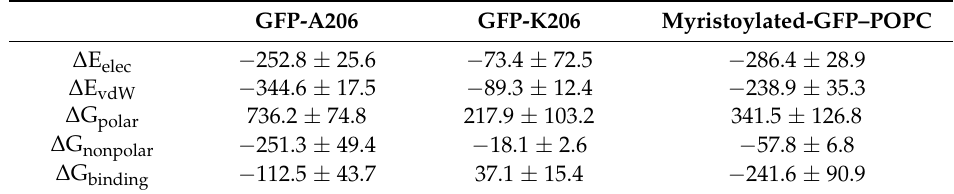
Table 1. Binding free energy (kJ/mol) for the dimerization of GFP, GFP-A206K monomer, and insertion of myristoylated GFP in the lipid bilayer and contributions of solvation, van der Waals, and electrostatic interactions, and entropic terms using the same trajectory